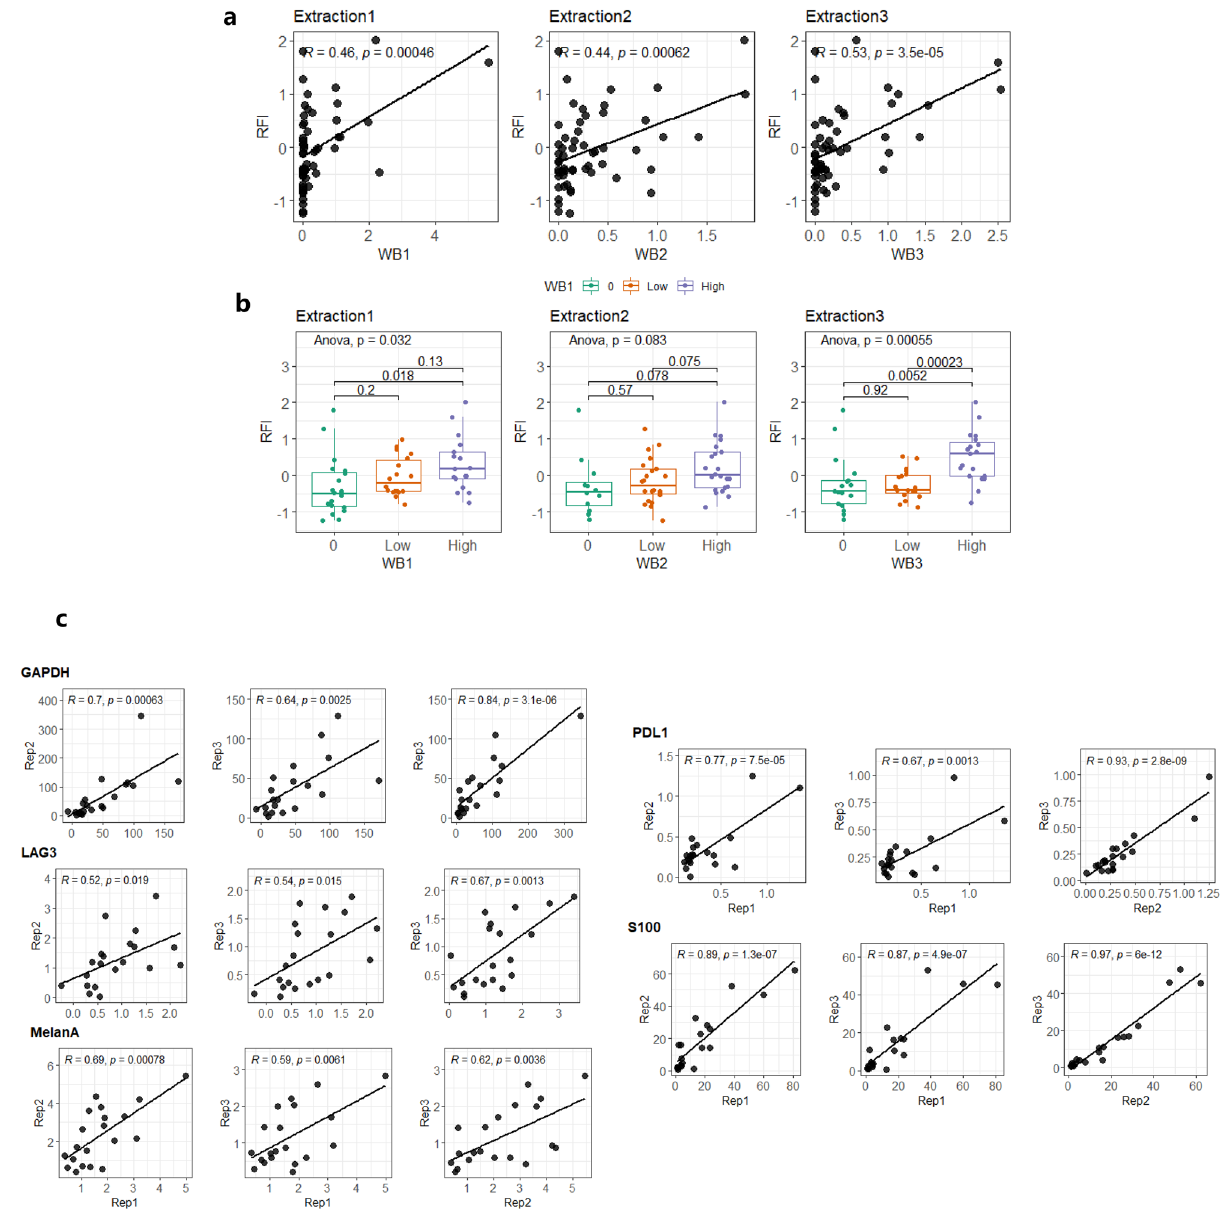
Figure 5. Expression correlation between RPPA and western blot in melanoma 63 FFPE patient samples. ( a ) Direct plotting of expression levels between western blot (arbitrary unit) and RPPA (RFI) from three independent experimental replicates. R 2 and Pearson correlation are shown accordingly. ( b ) Boxplots representing RFI from three equally divided expression categories based on western blot data. Statistical test results are shown (ANOVA). ( c ) RPPA expression correlation between individual experimental replicates. Five protein markers (GAPDH, PDL1, LAG3, S100, MelanA) in 63 melanoma FFPE patients were tested and R 2 and Pearson correlation coefficients are shown